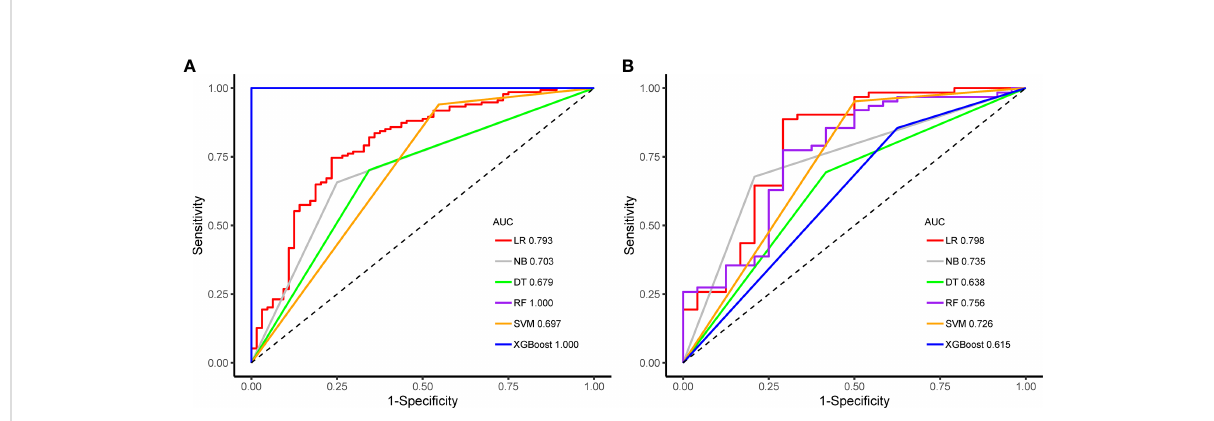
FIGURE 6 Receiver operating characteristic curves of the six machine learning classi fi ers predicting the high Ki-67 status in the training (A) and test sets (B)